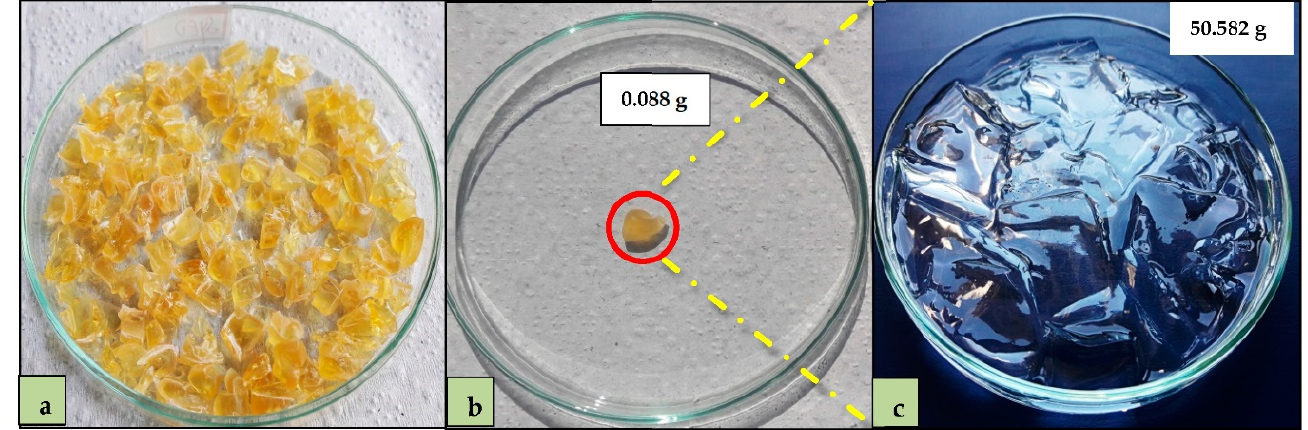
Figure 1. Alginate-acrylic SAP ( a ) after drying and cutting ( b ) a small piece for swelling test and ( c ) hydrogel after 24 h in water.